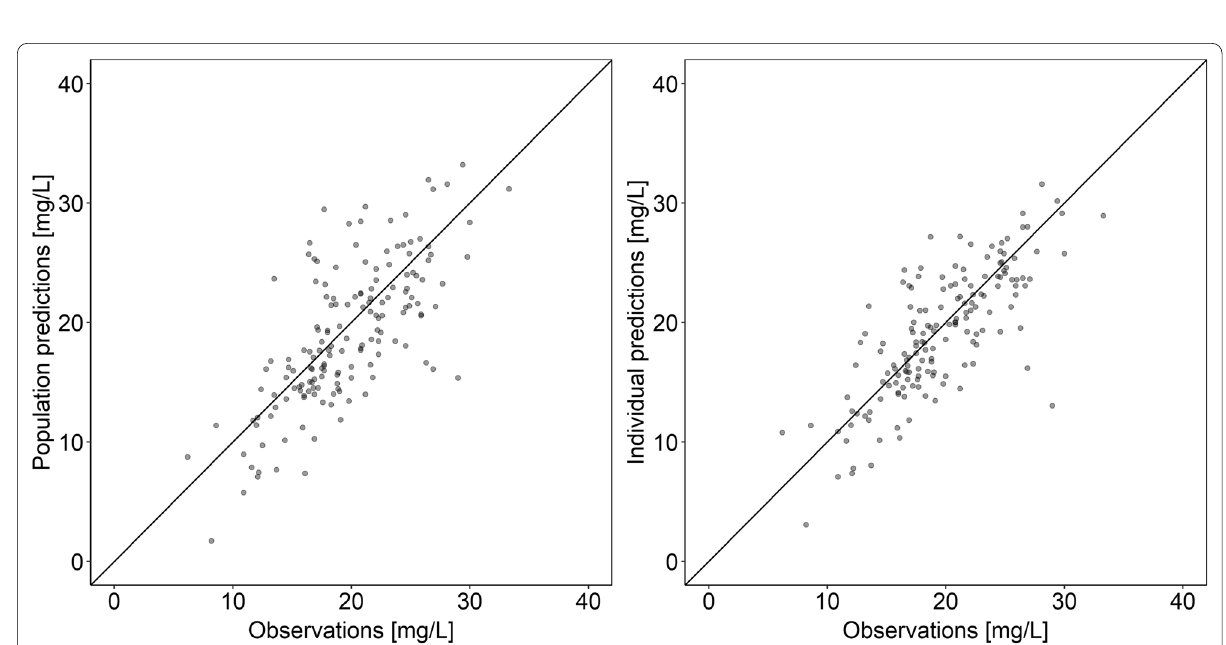
Fig. 2 Goodness-of-fit plots for the final population pharmacokinetic model of vancomycin in critically ill patients undergoing renal replacement therapy and CytoSorb ® therapy. Points: observations, lines: line of